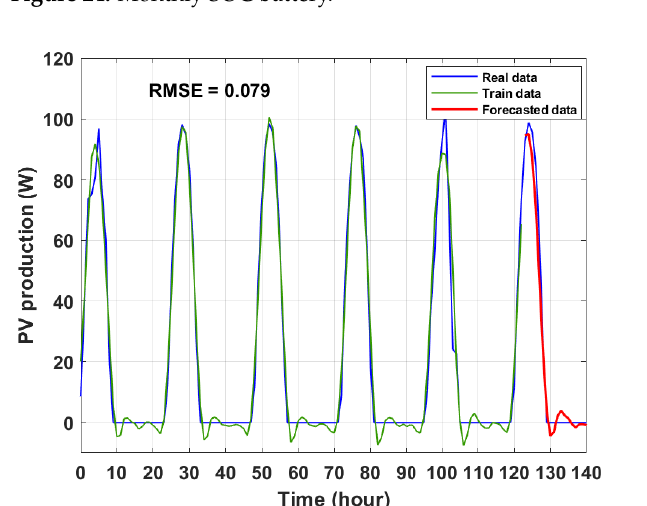
Figure 24. Monthly SOC battery.